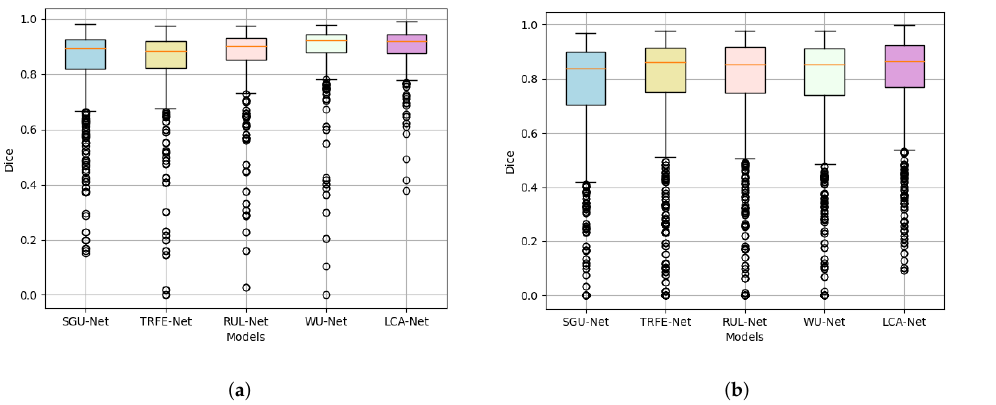
Figure 8. Boxplot of dice scores for each segmentation model. ( a ) Boxplot of dice scores on the TN-SCUI2020 dataset; and ( b ) boxplot of dice scores on the TN3k dataset. Median, interquartiles, minimum and maximum dice are